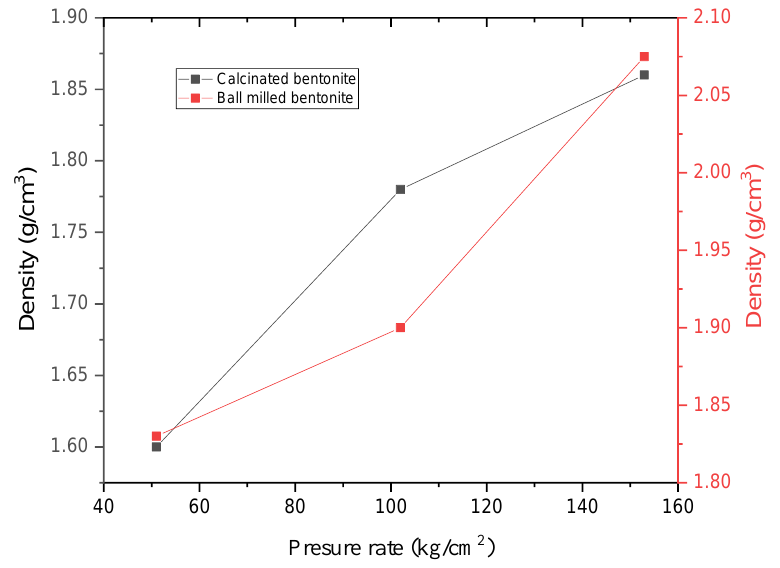
Figure 4. Effect of the pressure rate on the density of both calcinated and ball-milled bentonite.